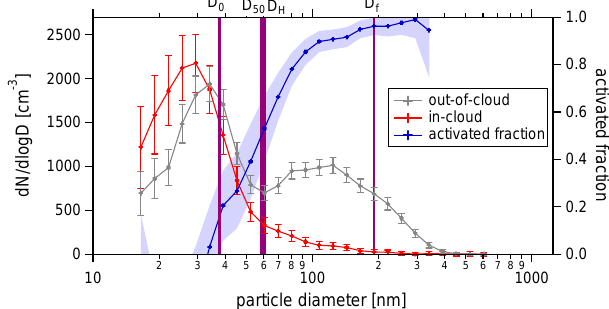
Figure 4. Average number size distribution of total aerosol particles (grey crosses, out of cloud) and of interstitial aerosol particles (red crosses, in cloud). The error bars correspond to the individual statis- tical errors calculated as described in Sect. 2.5. The activated frac- tion (blue crosses represent grey minus red, divided by grey; shaded area is the range of the statistical error of the data points) is plotted on the right axis. To assure comparability of the size distributions, their averaging times were chosen to be unambiguous with respect to LWC for in-cloud (mean LWC = 0.089gm − 3 ) and out-of-cloud conditions (mean LWC = 0.016gm − 3 ) within a short time inter- val (in cloud: 19 September 2012, 15:26–16:25UTC; out of cloud: 19 September 2012, 17:30–18:00UTC). The vertical lines